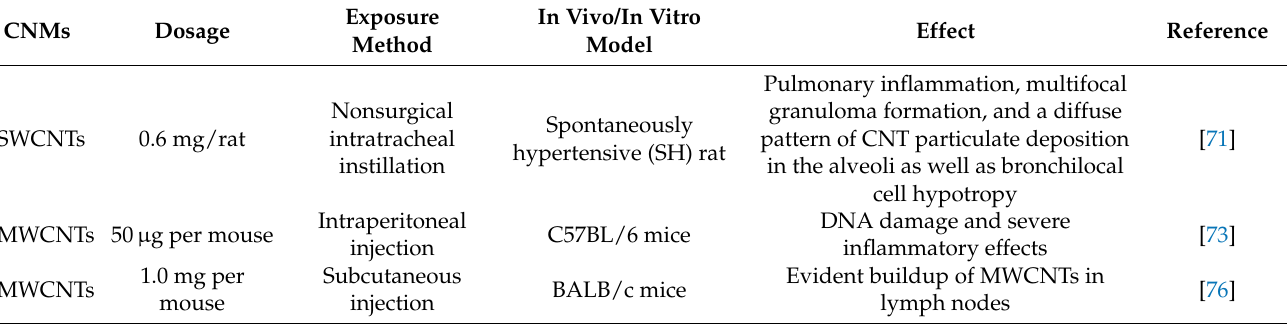
Table 3. Adverse in vivo effects of